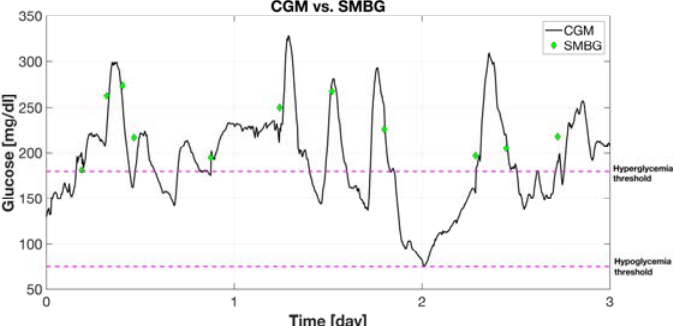
real-time the current BG and trend and generate acoustic and visual alerts for hypo/ hyperglycemia.